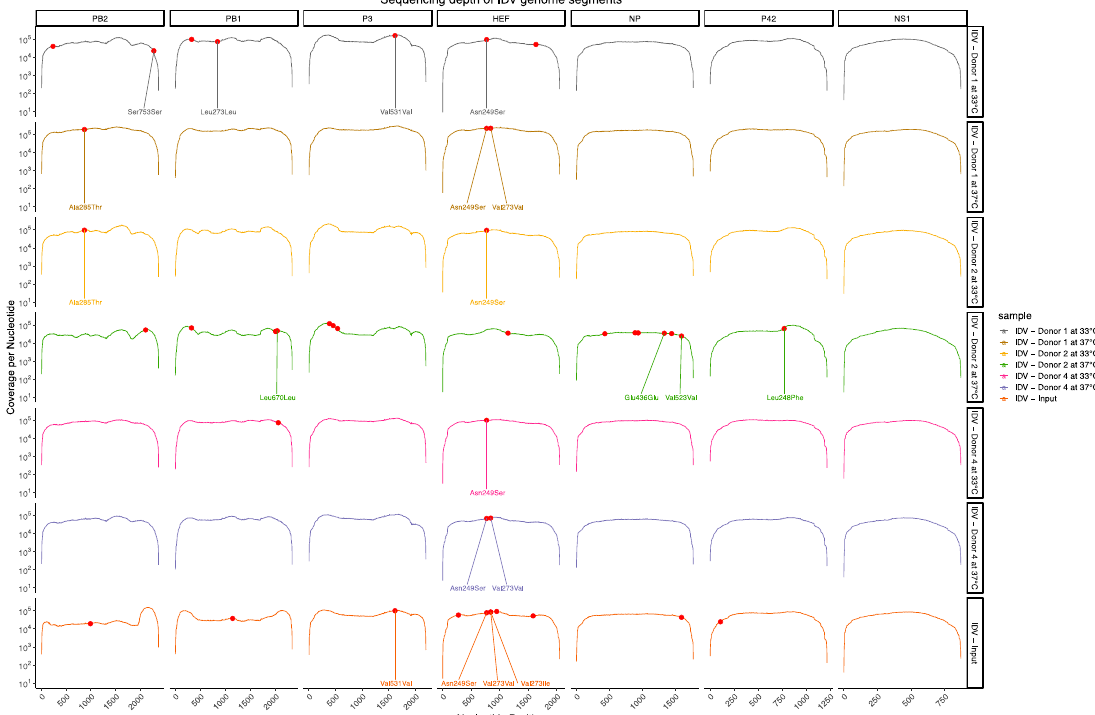
Figure 2. Sequencing depth of IDV genome segments. To assess eventual host adaptation during the serial-passaging of IDV on well-differentiated hAEC cultures, the complete genome of the parental inoculum and the viruses that were obtained after 3 serial-passages at 33 °C or 37 °C were amplified and sequenced. The sequence coverage per nucleotide (y-axis) and corresponding nucleotide position (x-axis) is provided for the 7 different genomic segments from the parental and serial-passaged viruses. The nucleotide variants are highlighted with a red point, whereas the resulting amino acids are only annotated for those variants with a detection frequency above 10%, as indicated in Table 2.